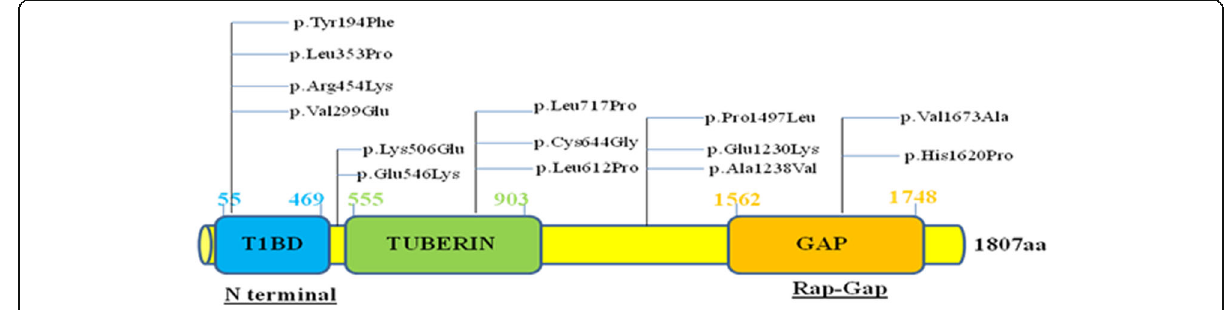
Fig. 1 Schematic representation of 13 novel TSC2 missense variants identified in respective domains of TSC2